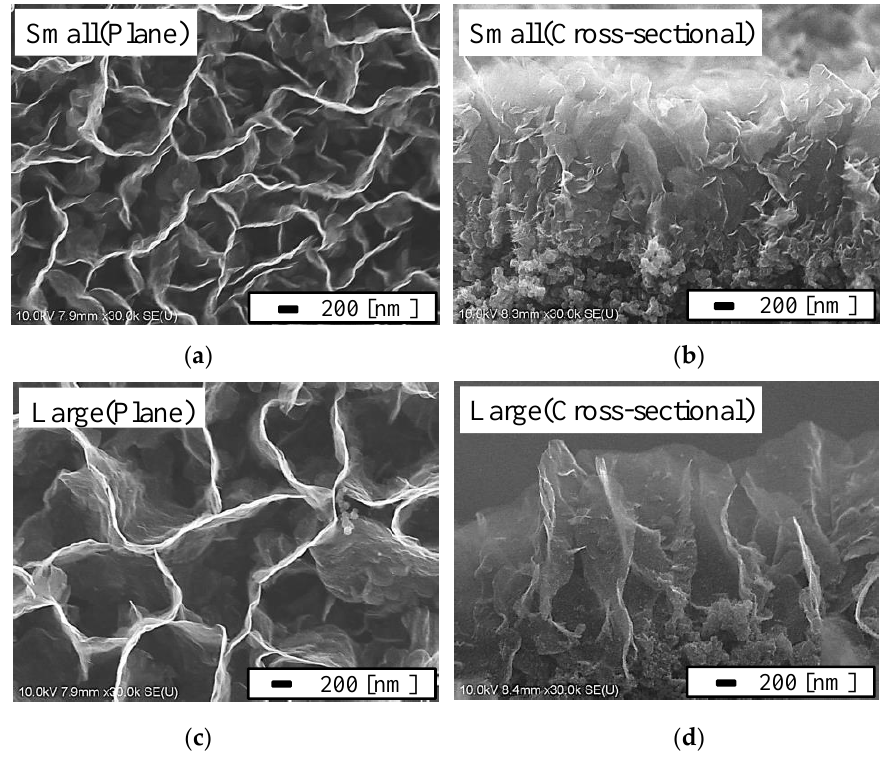
Figure 9. ( a , c ) Plane view and ( b , d ) cross-sectional view of the SEM images of CNWs grown on MPL with ( a , b ) a small gap area (0.37 µm 2 ) and ( c , d ) a large gap area (0.79 µm 2 ).